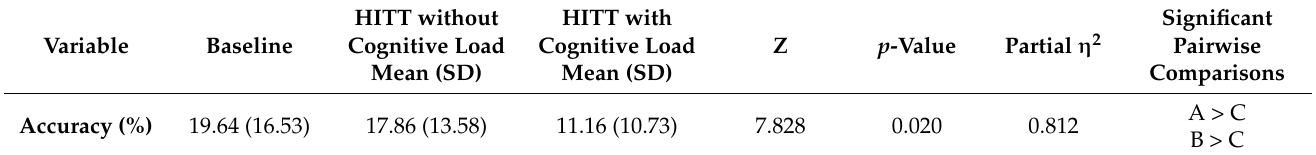
Table 1. Effects of HITT sessions, with and without cognitive load, in tennis serve accuracy.